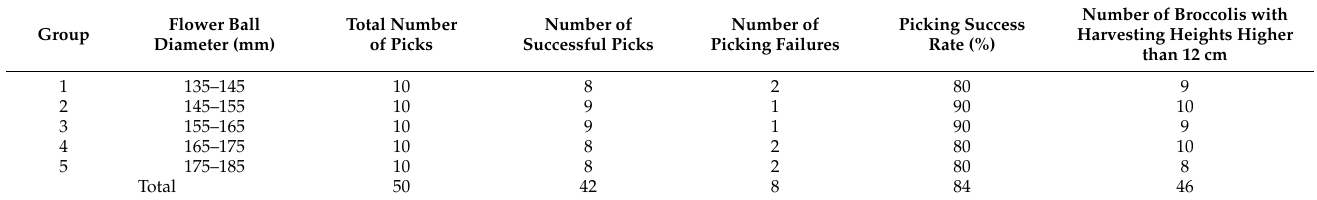
Table 3. The success rate of picking.